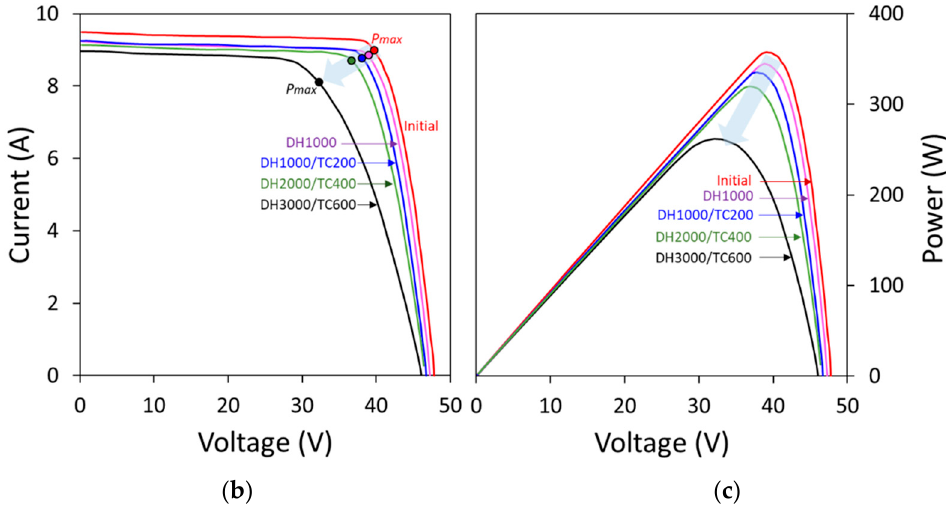
Figure 8. ( a ) Change of module performance parameters with respect to combined DH-TC test sequences and corresponding ( b ) current–voltage and ( c ) power-voltage plots of selected modules. Table 3. Module performance parameters with sequences of DH-TC combined acceleration test.